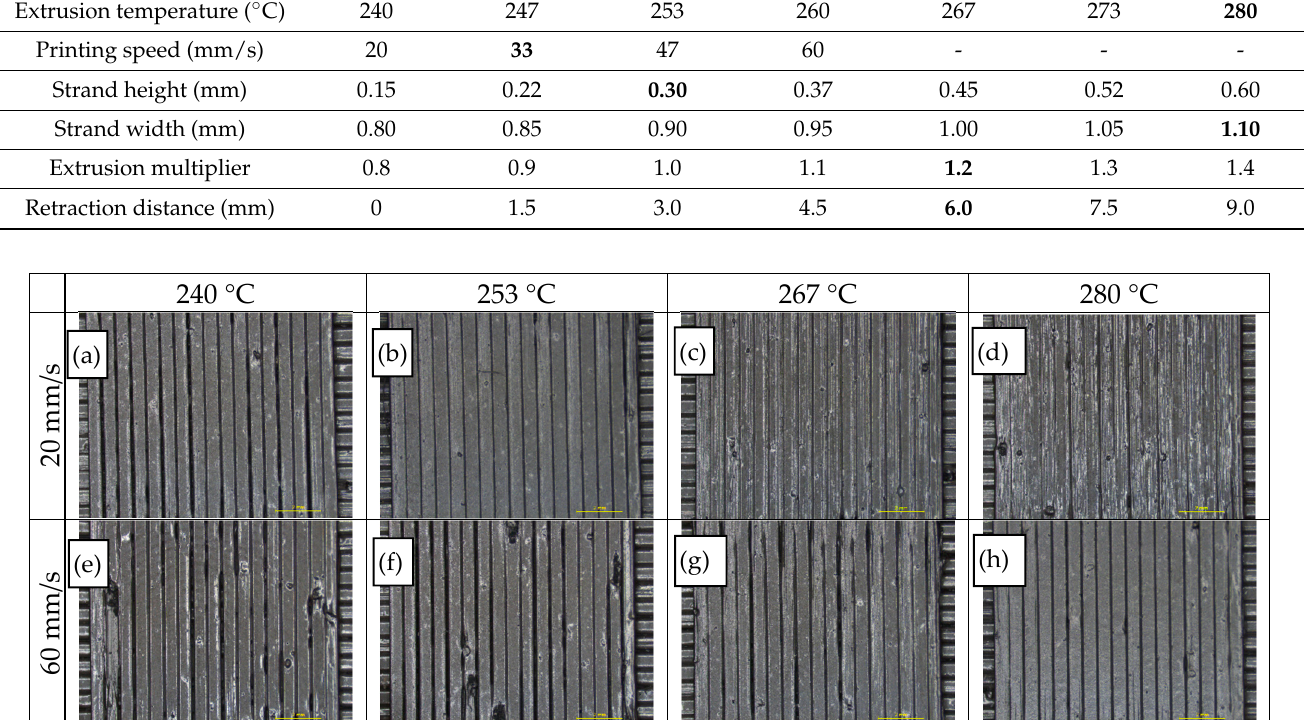
Figure 12. Optical inspection via stereomicroscope (7×) of specimens obtained from varying extrusion temperatures (ET) and printing speeds (PS): ( a – d ) SP = 20 mm/s and ET = 240, 253, 267, 280 °C from left to right; ( e – h ) SP = 60 mm/s and ET = 240, 253, 267, 280 °C from left to right.